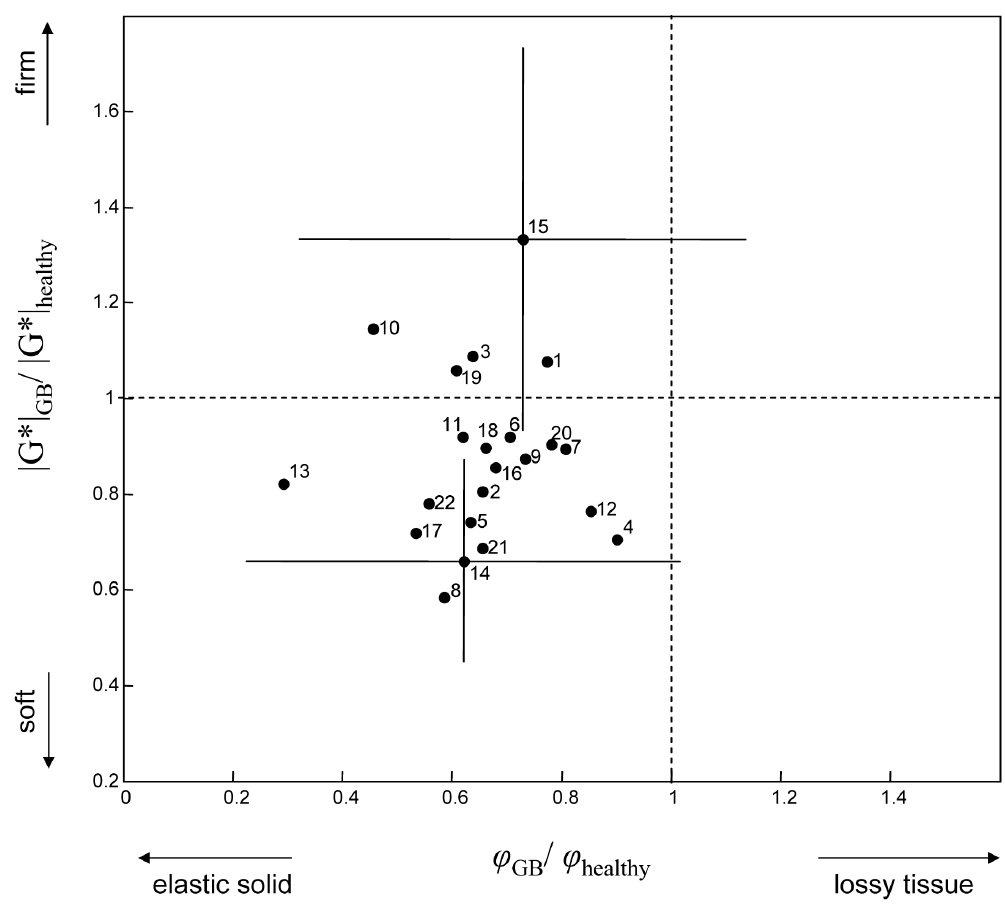
Figure 3. Viscoelastic properties of GB based on the parameter ratios of |G*| and Q between tumor and healthy reference tissue (ref). Numbers correspond to the list of tumors in tables 1 and 2. For illustration purposes, standard deviations (SD) indicating intratumoral heterogeneity are shown for the two tumors presented in figure 2 (solid lines in 14, and 15). All SD values are given in table 2.